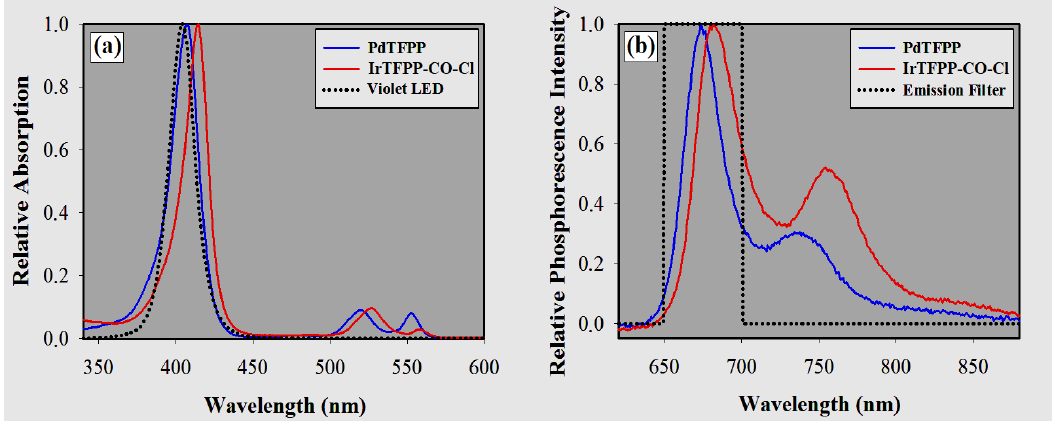
Figure 5. ( a ) Absorption spectra in chloroform and ( b ) phosphorescence spectra in polystyrene for PdTFPP and IrTFPP-CO-Cl at 23 ◦